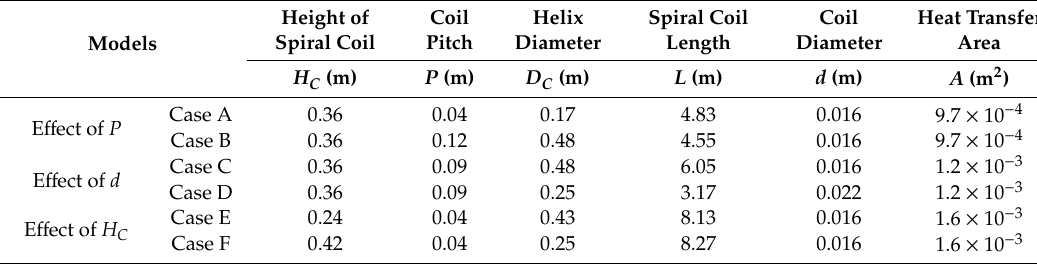
Table 4. Shell geometrical parameters